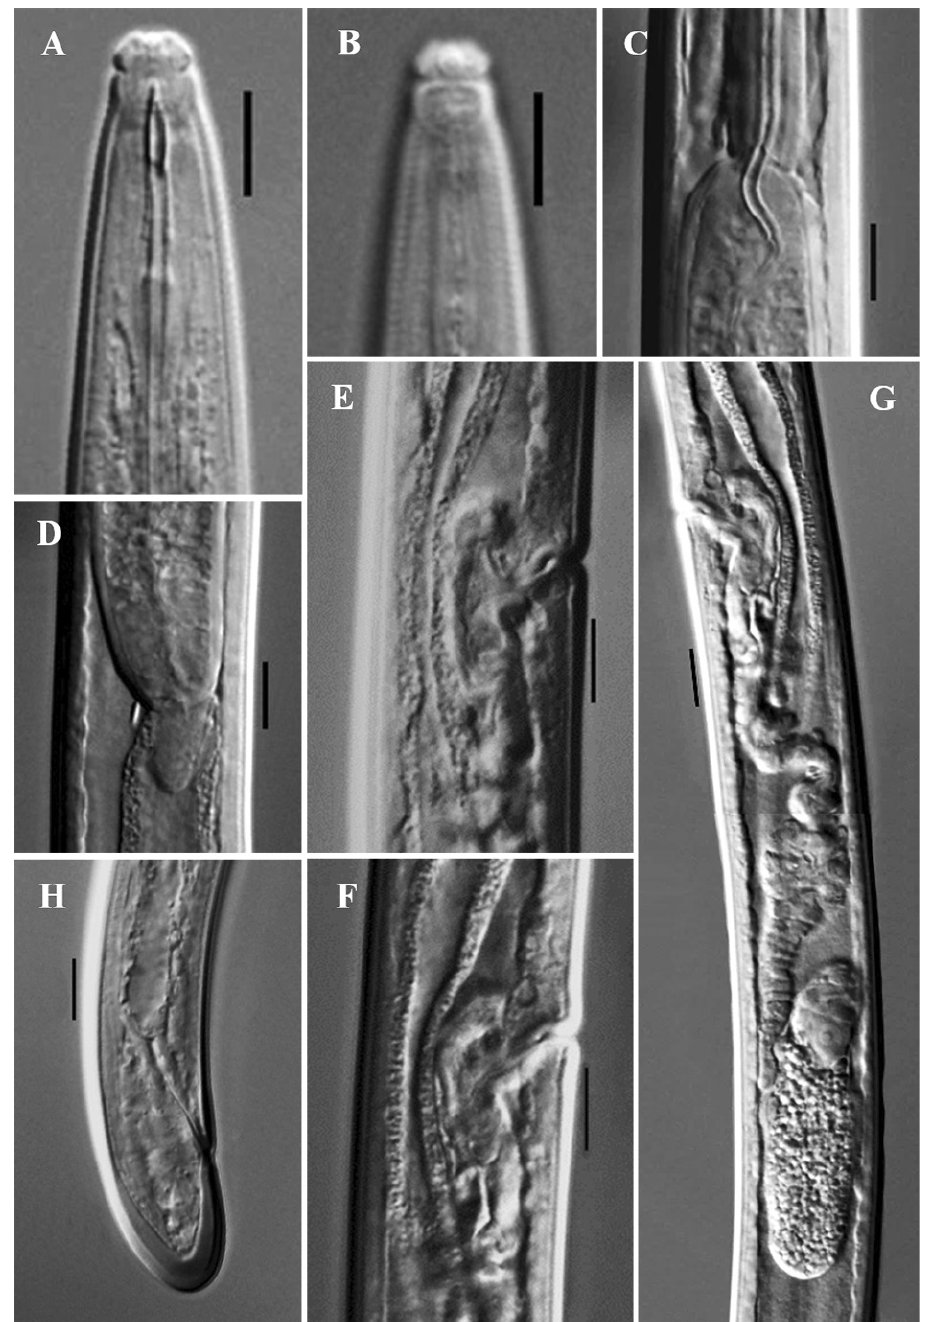
Fig. 1. Axonchium nitidum Jairajpuri, 1964 (LM photographs). A . Anterior region. B . Anterior end showing amphid. C . Junction between two parts of pharynx. D . Cardia. E – F . Female vulva and vagina. G . Female genital branch. H . Female posterior region. Scale bars: A–F, H = 10 µm; G = 20